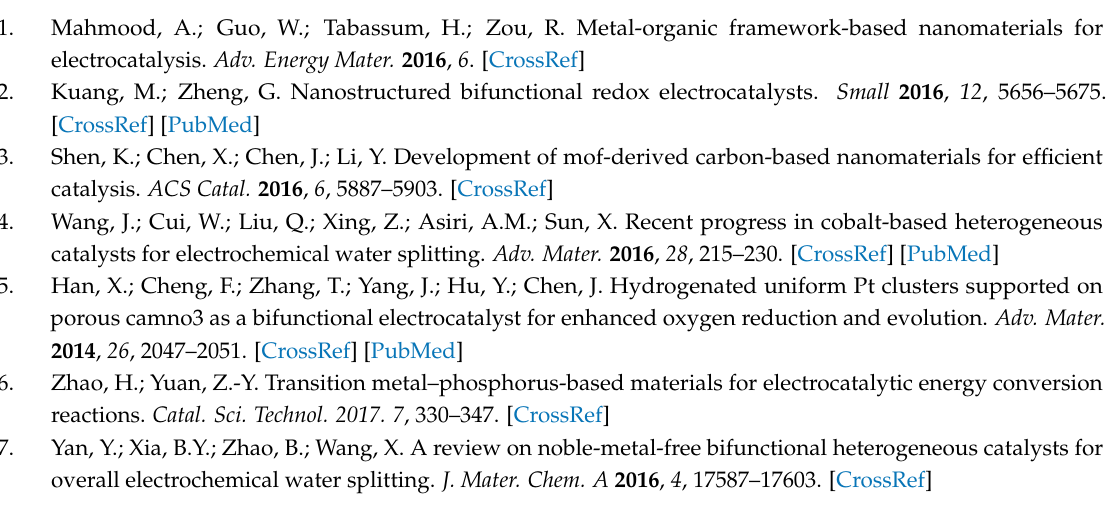
Figure S1: TEM images of ZIF-67; Figure S2: XRD patterns of ZIF-67 simulated, ZIF-67 and ZIF-NS; Figure S3: The energy-dispersive X-ray spectroscopy (EDS) spectrum of CoP-NS/C; Figure S4: High-resolution XPS patterns for C 1s of CoP-NS/C; Figure S5: (a) XRD patterns; and (b) TEM image of CoP/C; Figure S6: N 2 adsorption/desorption isotherms of CoP/C; Figure S7: XPS spectra of CoP/C: (a) survey spectrum; (b) Co 2p; (c) P 2p; and (d) C 1s; Figure S8: (a) XRD patterns; and (b) SEM image (c) XPS survey spectrum of CoP; Table S1: Comparison of HER performance in 0.5 M H 2 SO 4 for CoP-NS/C with other transition metal phosphide catalysts; Table S2: Comparison of HER performance in 1 M KOH for CoP-NS/C with other transition metal phosphide